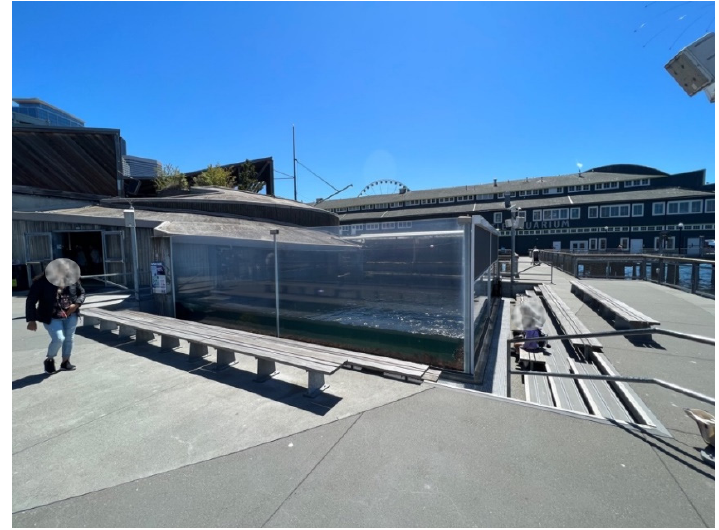
Figure 3. Photo shows the Harbor seal exhibit from the outside viewing area.